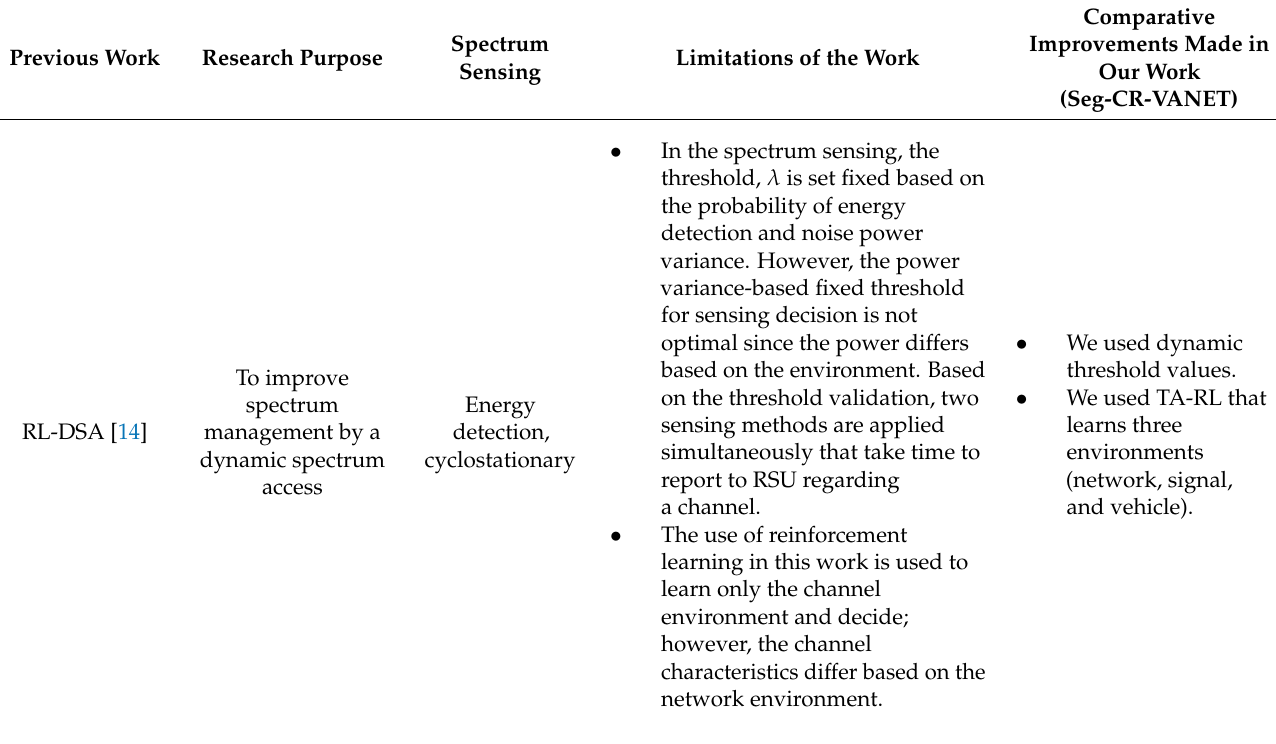
Table 5. Comparison of existing